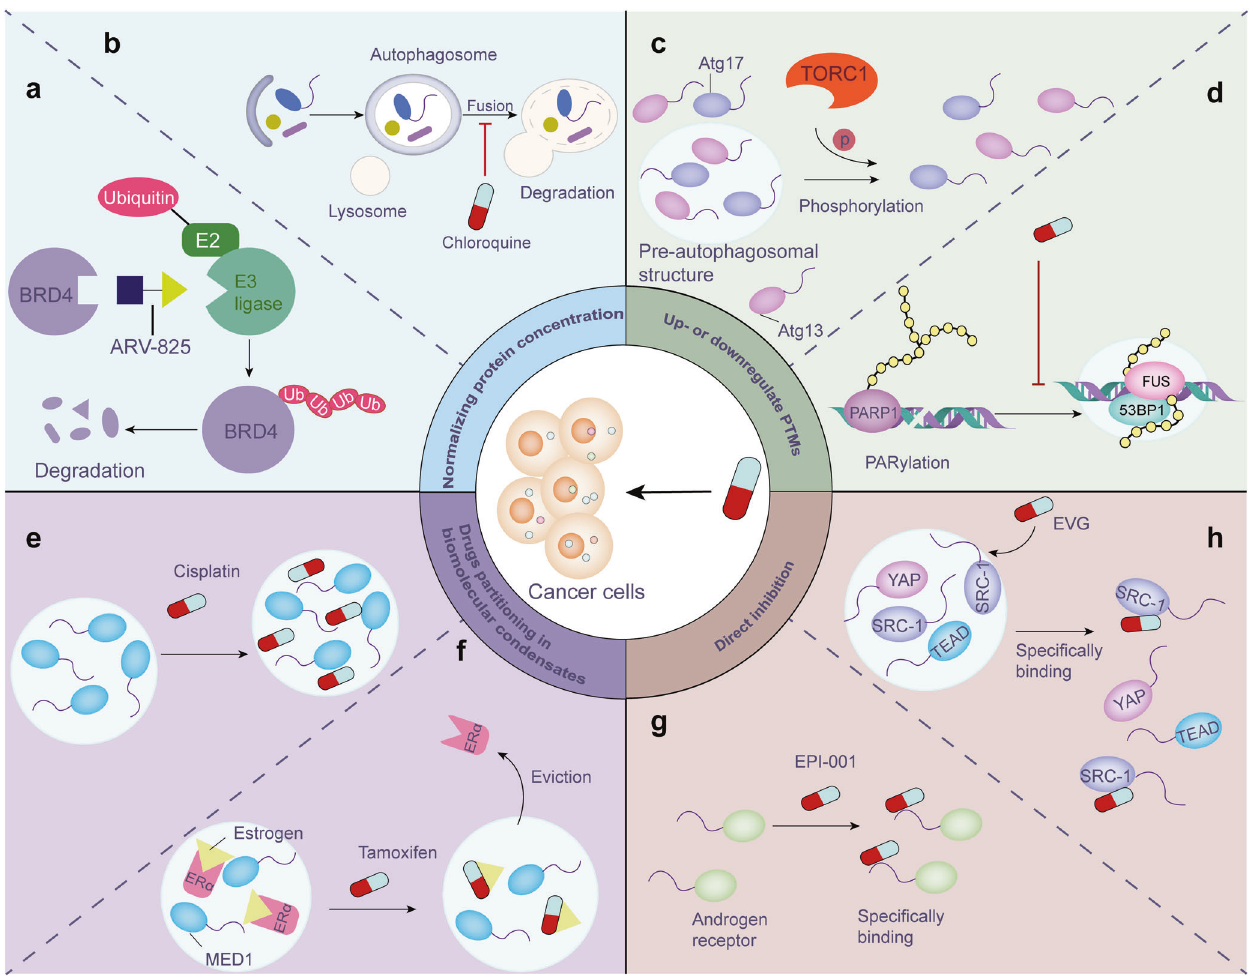
Fig. 7 Future prospects of cancer treatment via regulating LLPS. a ARV-825, a novel PROTAC, ef fi ciently degrades BRD4 protein in BL cell lines by linking BRD4 to E3 ubiquitin ligase. b Chloroquine primarily blocks autophagy by impairing autophagosome-lysosomal fusion, thereby upregulate target protein level. c Phosphorylation mediated by activated TORC1 signi fi cantly inhibits LLPS and impairs autophagosome prestructure (PAS) formation. d Inhibition of PARylation prevents the formation of DNA damage repair foci. e Cisplatin preferentially concentrates in biomolecule condensates, which can help improve drug ef fi cacy. f Tamoxifen ef fi ciently expels ER α from MED1 condensates via speci fi cally partitioning into these condensates. g The small-molecule compound EPI-001 selectively binds to the IDR of the androgen receptor, thereby slowing the progression of castration-resistant prostate cancer. h EVG can directly target the SRC-1/YAP/TEAD droplets to restrict cancer cell growth in a YAP-dependent